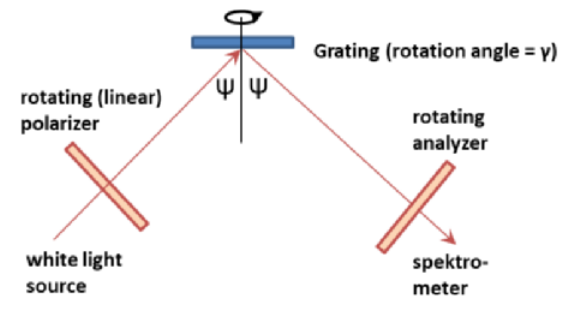
Fig. 1. Scheme of the basic measurement